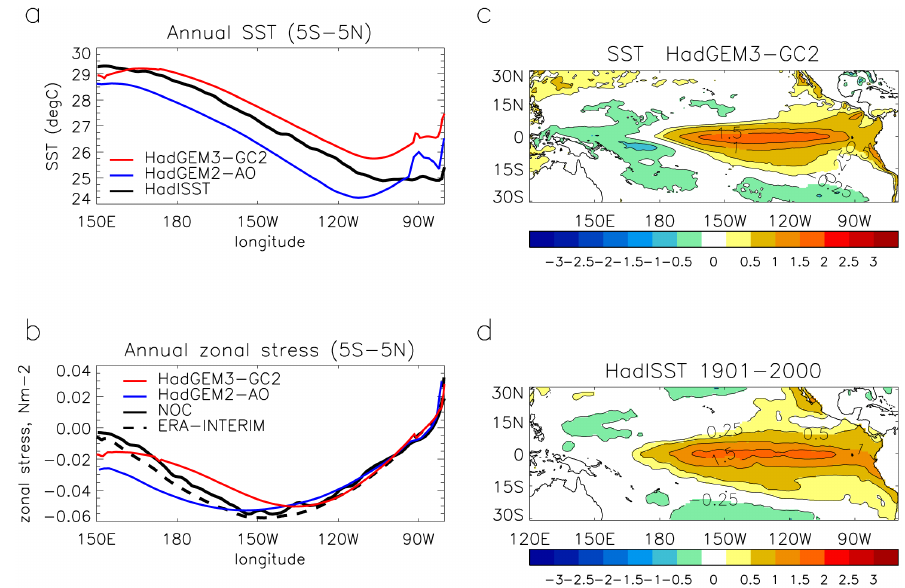
Figure 15. (a) Annual mean Pacific SST averaged over 5 ◦ N–5 ◦ S for the CLIM experiment. Black lines show HadISST. (b) Annual mean Pacific wind stress averaged over 5 ◦ N–5 ◦ S for the CLIM experiment. Black lines show ERA-I (dashed) and Southampton Oceanogra- phy Centre climatology (Josey et al., 1998) (solid) (c) El Niño SST composite from HadGEM3-GC2 CLIM experiment. (d) El Niño SST composite from HadISST observations. Composites are of events with a Niño 3.4 SST anomaly > 0 .